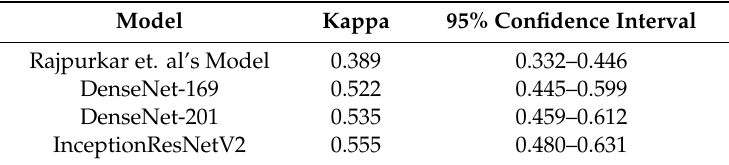
Table 3b. Model Performance Summary—Finger. Table 5. Model Performance